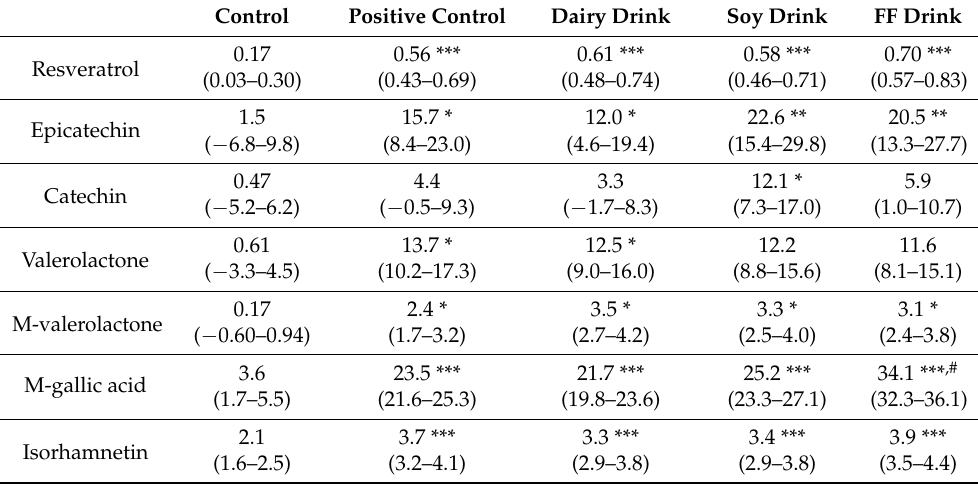
Table 2. Peak plasma concentration of sum of free and conjugated polyphenols and metabolites after consumption of different test products ( n = 32).